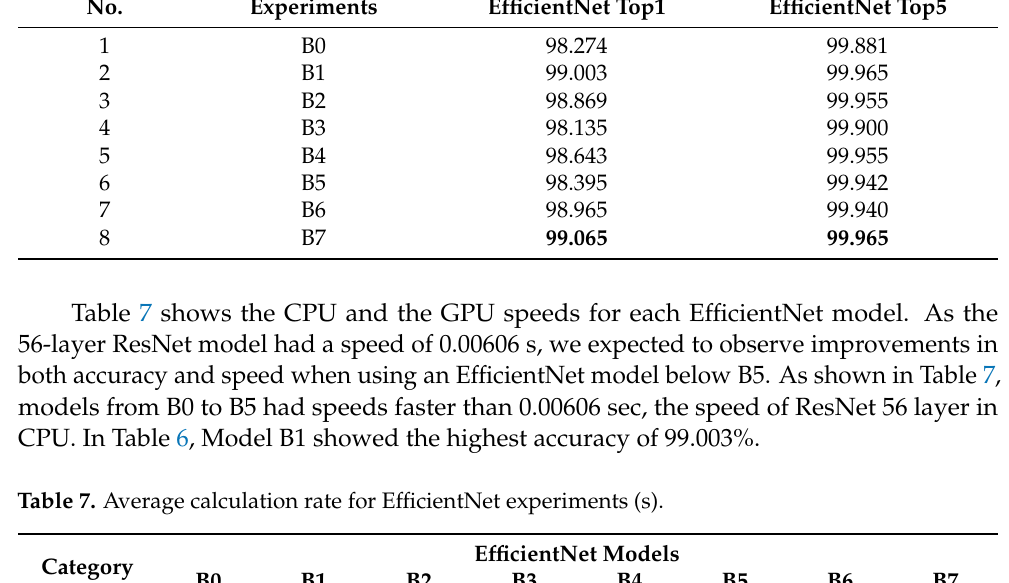
Table 6. EfficientNet Experiment showing top 1 and top 5 accuracies with 8000 images per class (%). No.